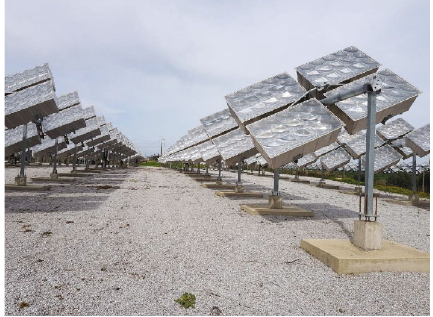
Figure 11: Concentration PV plan Evora,